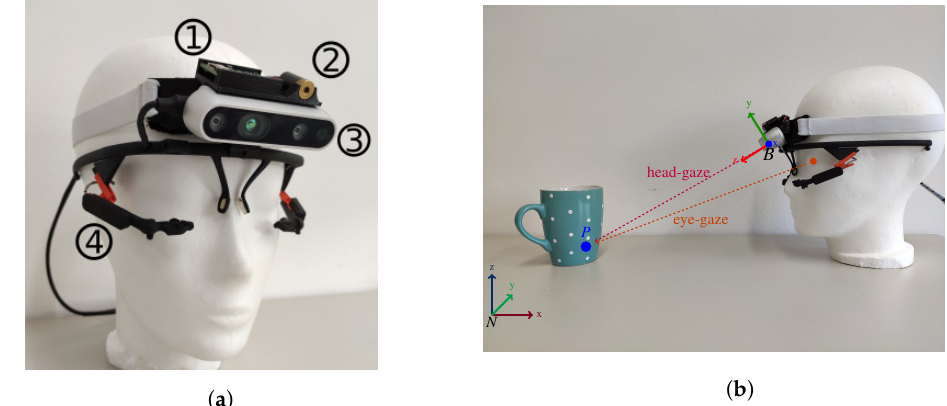
Figure 1. Proposed head interface ( a ) and depiction of head- and eye-gaze vectors ( b ). The head interface ( a ) consists of a pupil core binocular USB-C mount headset (cid:175) and the custom camera mount uniting the depth camera (cid:174) , MARG-sensor (cid:172) and feedback laser (cid:173) . Image ( b ) depicts head- and eye-gaze vector origins from the interface to a world point P.